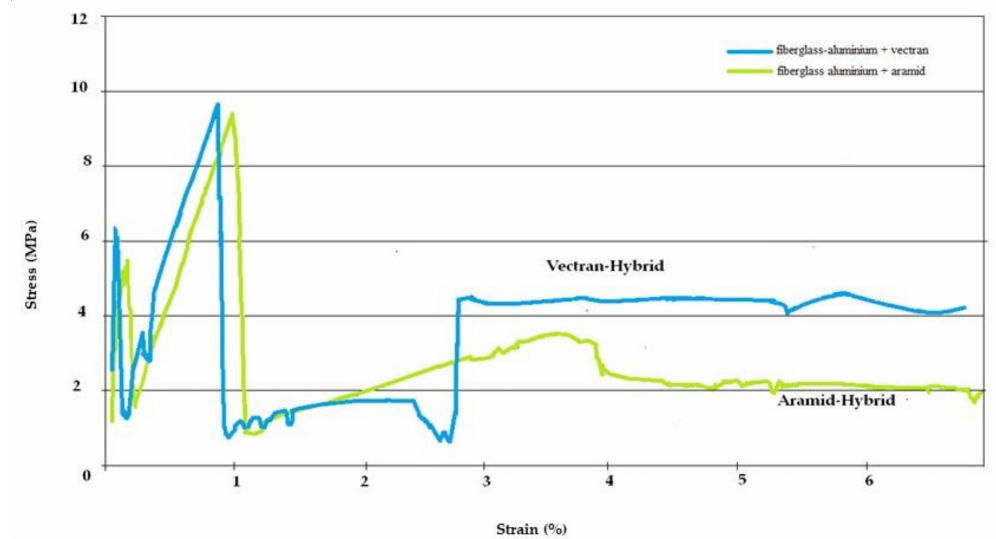
Figure 3. Stress–strain response of hybrid composite laminates during three-point bending